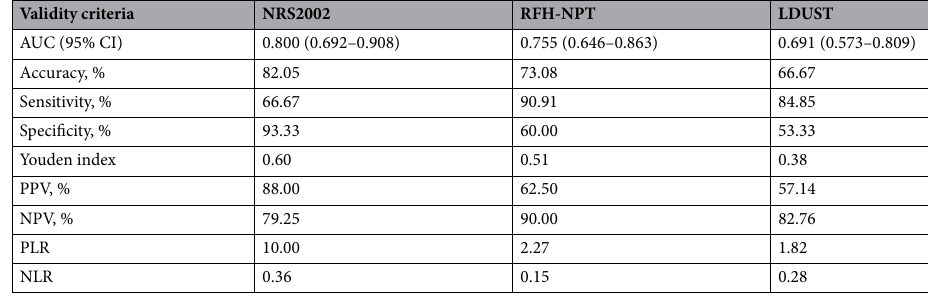
Table 4. Measures of diagnostic validity of screening tools. AUC the area under the ROC curves, PPV positive predictive value, NPV negative predictive value, PLR positive likelihood ratio, NLR negative likelihood ratio,